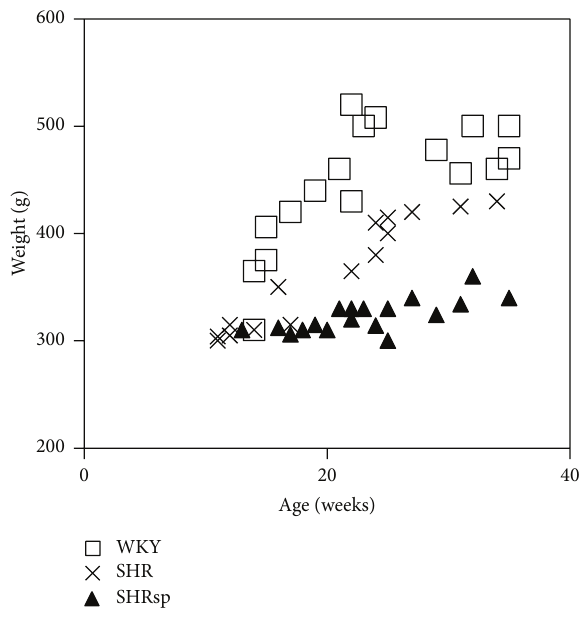
Figure 1: Body weight evolution from 11 to 35 weeks old for WKY ( 𝑛 = 17 ), SHR ( 𝑛 = 16 ), and SHRsp ( 𝑛 = 18 )